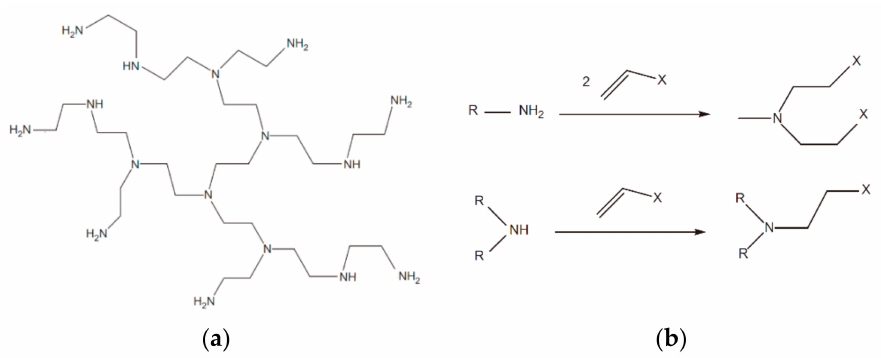
Figure 9. ( a ) Generalized structure of a hyperbranched polyethyleneimine, showing primary, sec- ondary, and tertiary amine groups; ( b ) addition of vinyl monomers to primary and secondary amines. X = phosphonate, sulfonate, or carboxylate [122].